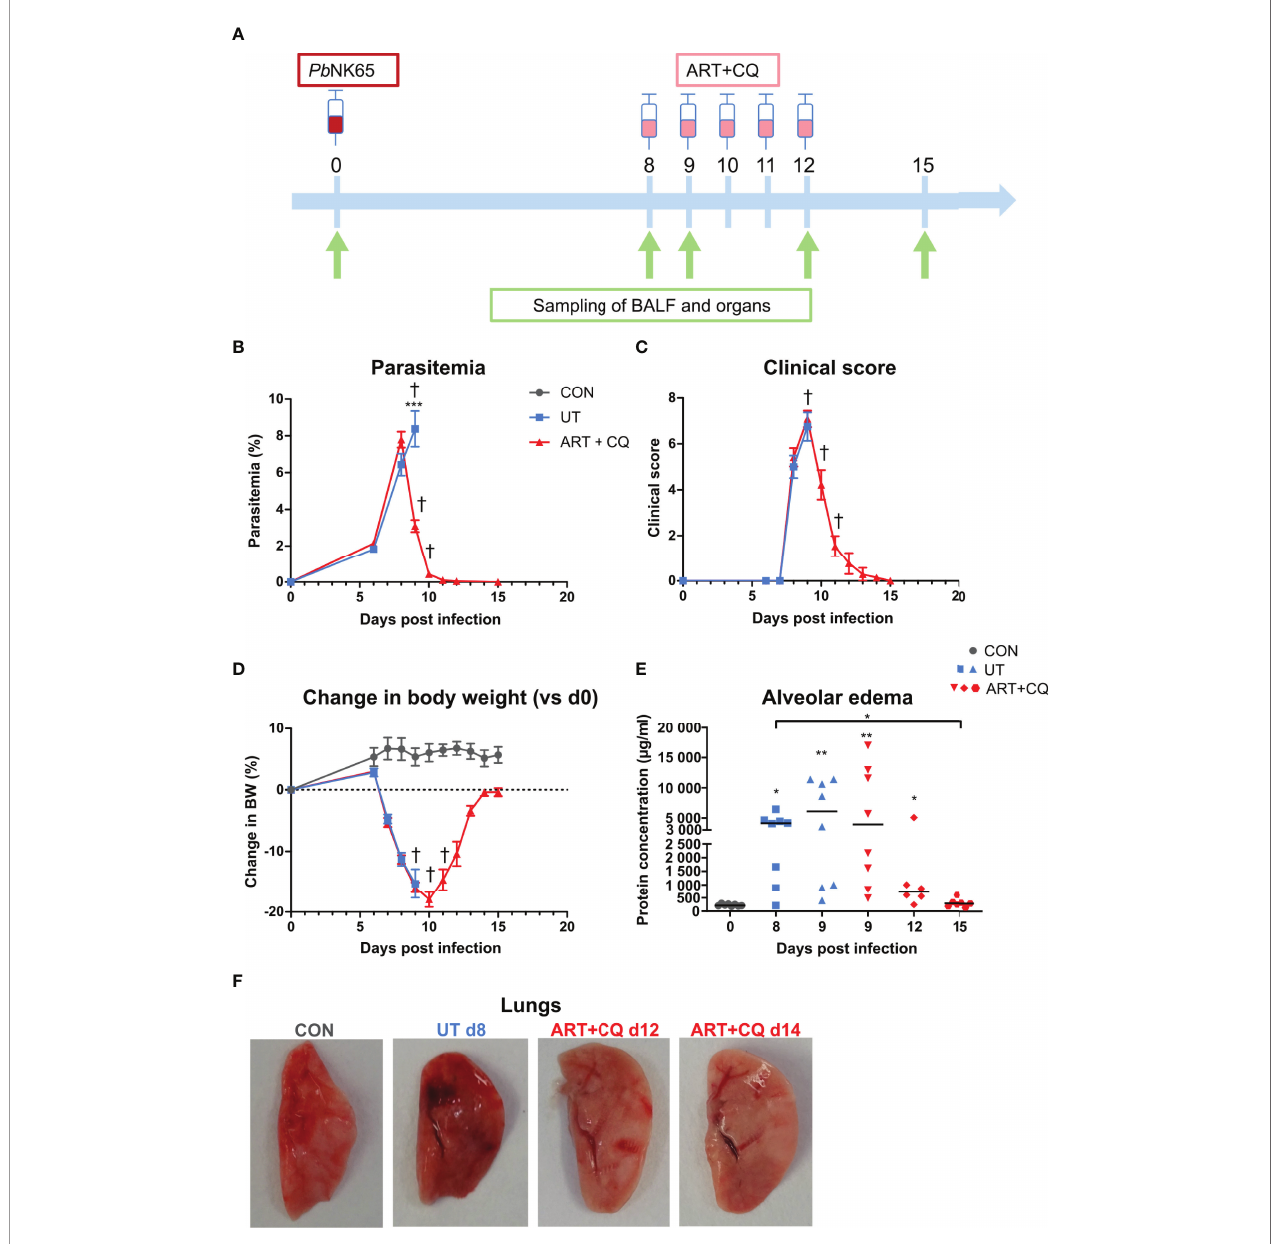
FIGURE 1 | A mouse model to study the resolution of malaria-associated acute respiratory distress syndrome (MA-ARDS) after antimalarial treatment. C57BL/6 mice were infected with PbNK65. Mice were injected daily from 8 until 12 days p.i. with 10 mg/kg ART + 30 mg/kg CQ (ART+CQ). (A) Schematic representation of the timing of infection and antimalarial treatments in the mouse model. (B) Parasitemia was determined using Giemsa-stained blood smears. (C) The clinical score was monitored daily starting at 6 days p.i. (D) The change in body weight was calculated compared to day 0 p.i. starting at 6 days p.i. (B, D) Compilation of two experiments. Data are means ± SEM. n=8 for uninfected controls (CON), n=8 – 16 for the infected untreated group (UT), n=7 – 21 for the infected ART+CQ-treated group. (E) The protein concentration in the BALF was determined as a measure of alveolar edema. Compilation of two experiments. Each symbol represents data of an individual mouse. n=8 for CON on day 0, UT at 8 and 9 days p.i and ART+CQ at 9 days p.i., n=6 for ART+CQ at 12 days p.i., n=7 for ART+CQ at 15 days p.i. (F) Representative pictures of the left